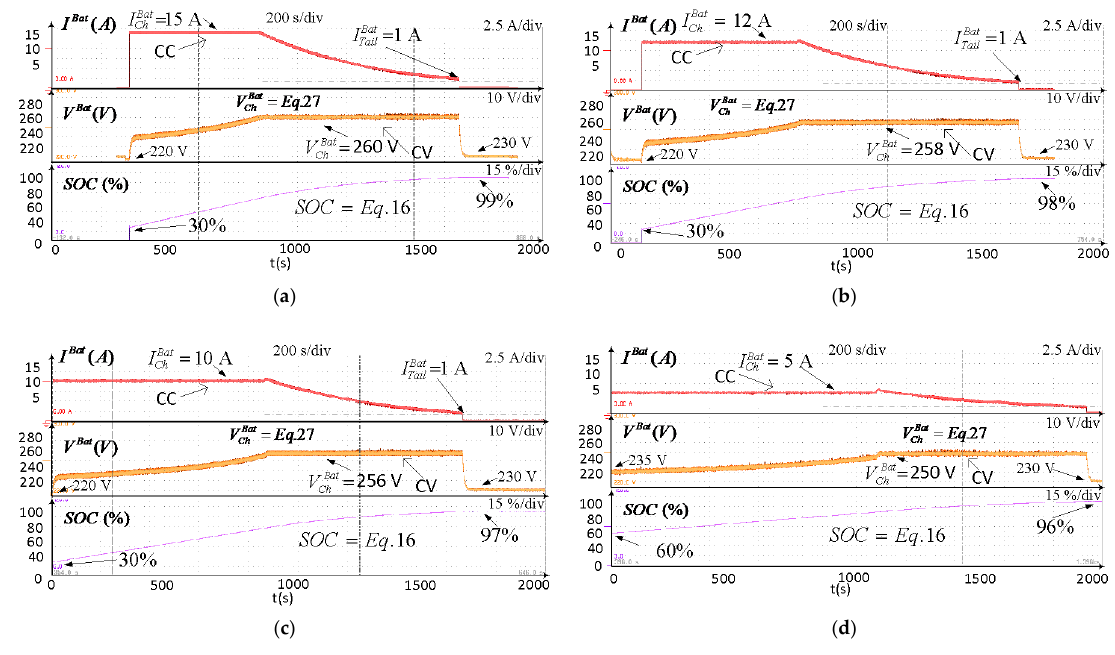
Figure 14. Experiment #1. Waveforms of the implemented charging procedure for different values of the charging current: ( a ) I (Ch)Bat = 15 A; ( b ) I (Ch)Bat = 12 A; ( c ) I (Ch)Bat = 10 A and ( d ) I (Ch)Bat = 5 A.